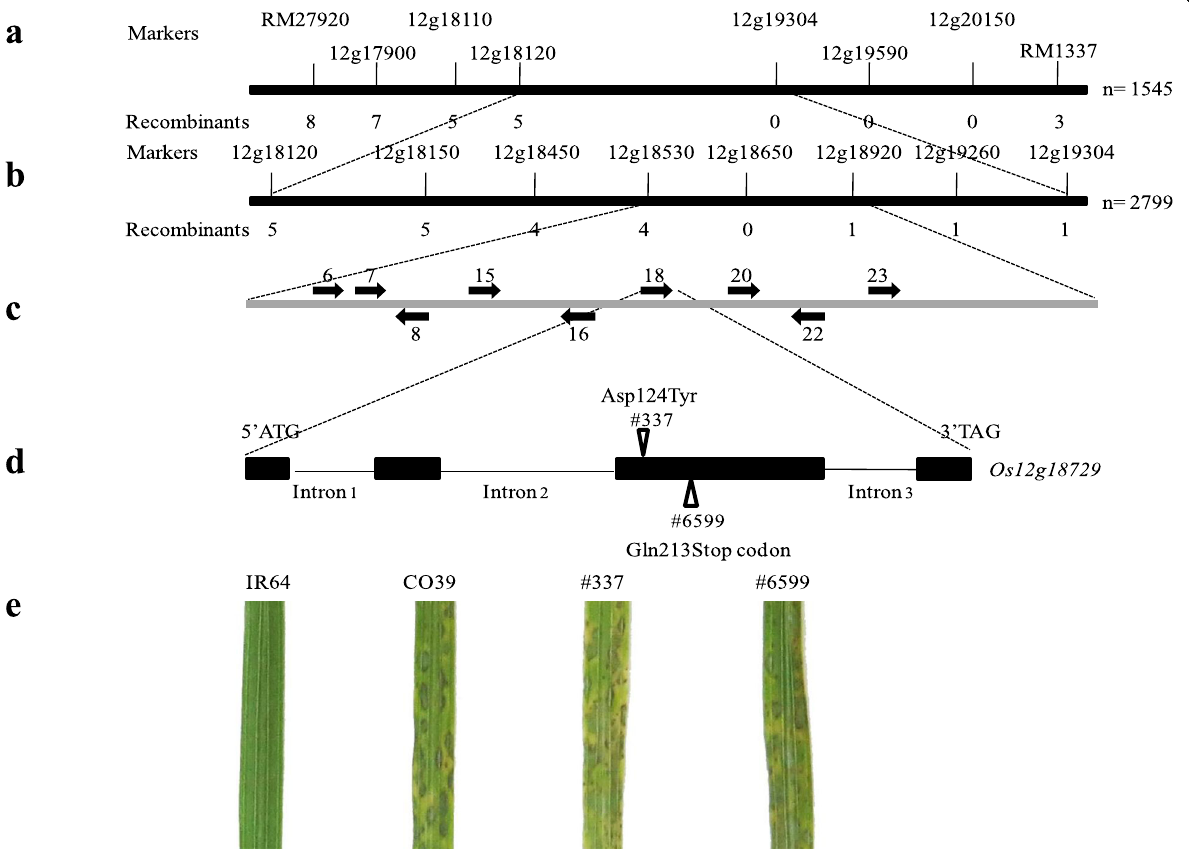
Fig. 1 Mapping and identification of Pita2. a Pita2 was mapped between 12 g18120 and RM1337 on chromosome 12. b Pita2 was fine mapped to 270 kb flanked by 12 g18530 and 12 g18920. The molecular markers and number of recombinants were listed above and underneath the thick line, respectively. The population size used for mapping is listed on the right. c Nine candidate genes of Pita2 were identified in the genomic region of IR64 delimited by markers of 12 g18530 and 12 g18920. The transcriptional direction was indicated by arrows. d Diagram of Pita2 . Two mutants of IR64 were indicated by triangle. The position of amino acid residue corresponding to the single nucleotide mutation was indicated. Exons were showed in filled boxes. e Reaction pattern of different varieties to 9475-1-3. The figures was not drawn in